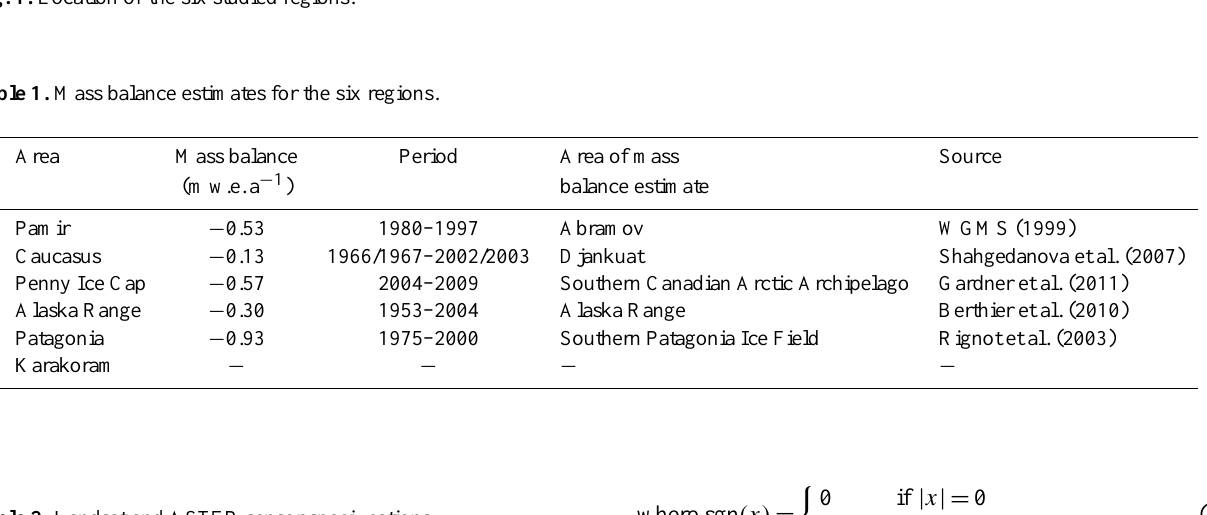
Table 2. Landsat and ASTER sensor